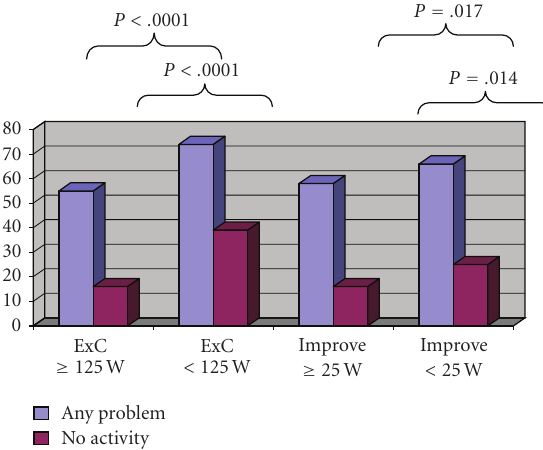
Figure 1: Percent of patients after OCR having any sexual problems (bright bars) or indicating sexual inactivity (dark bars) in subgroups of patients according to exercise capacity (left-sided pairs columns) and improvement of exercise capacity during OCR (right- sided pairs of columns) ExC: exercise capacity; improve: improve- ment in exercise capacity. OCR: outpatient cardiac